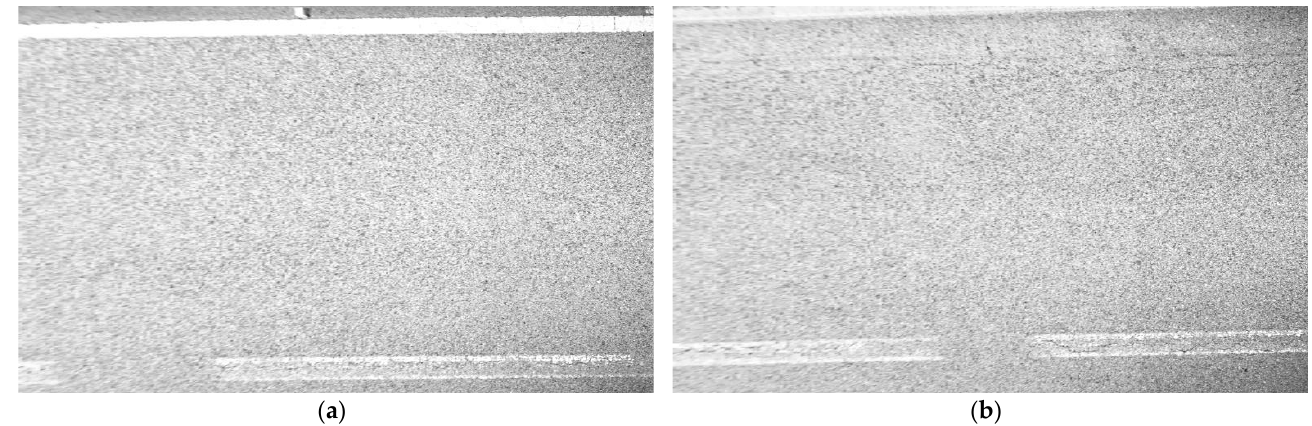
Figure 19. Images relating to the section [76,700; 76,800]: ( a ) longitudinal crack within the lower white lane marking (the system classi fi ed the image as non-crack); ( b ) longitudinal crack in the pavement and within the lower white lane marking (the system classi fi ed the image as non-crack).